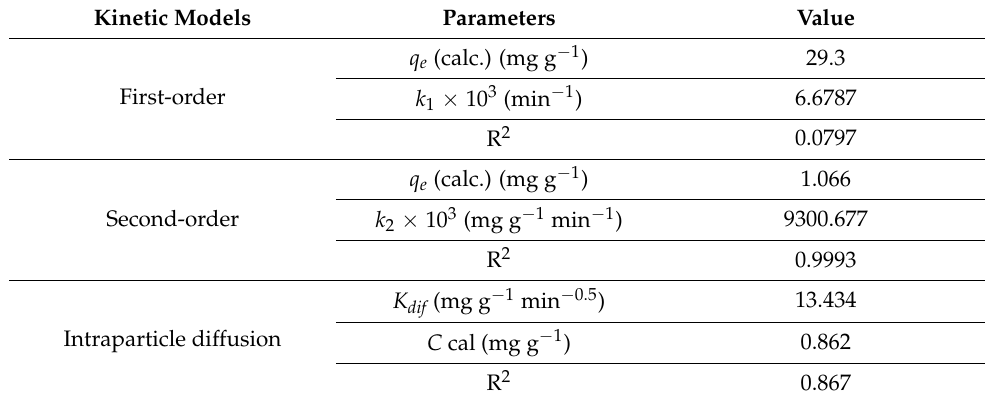
Table 4. Parameters of the different adsorption kinetics